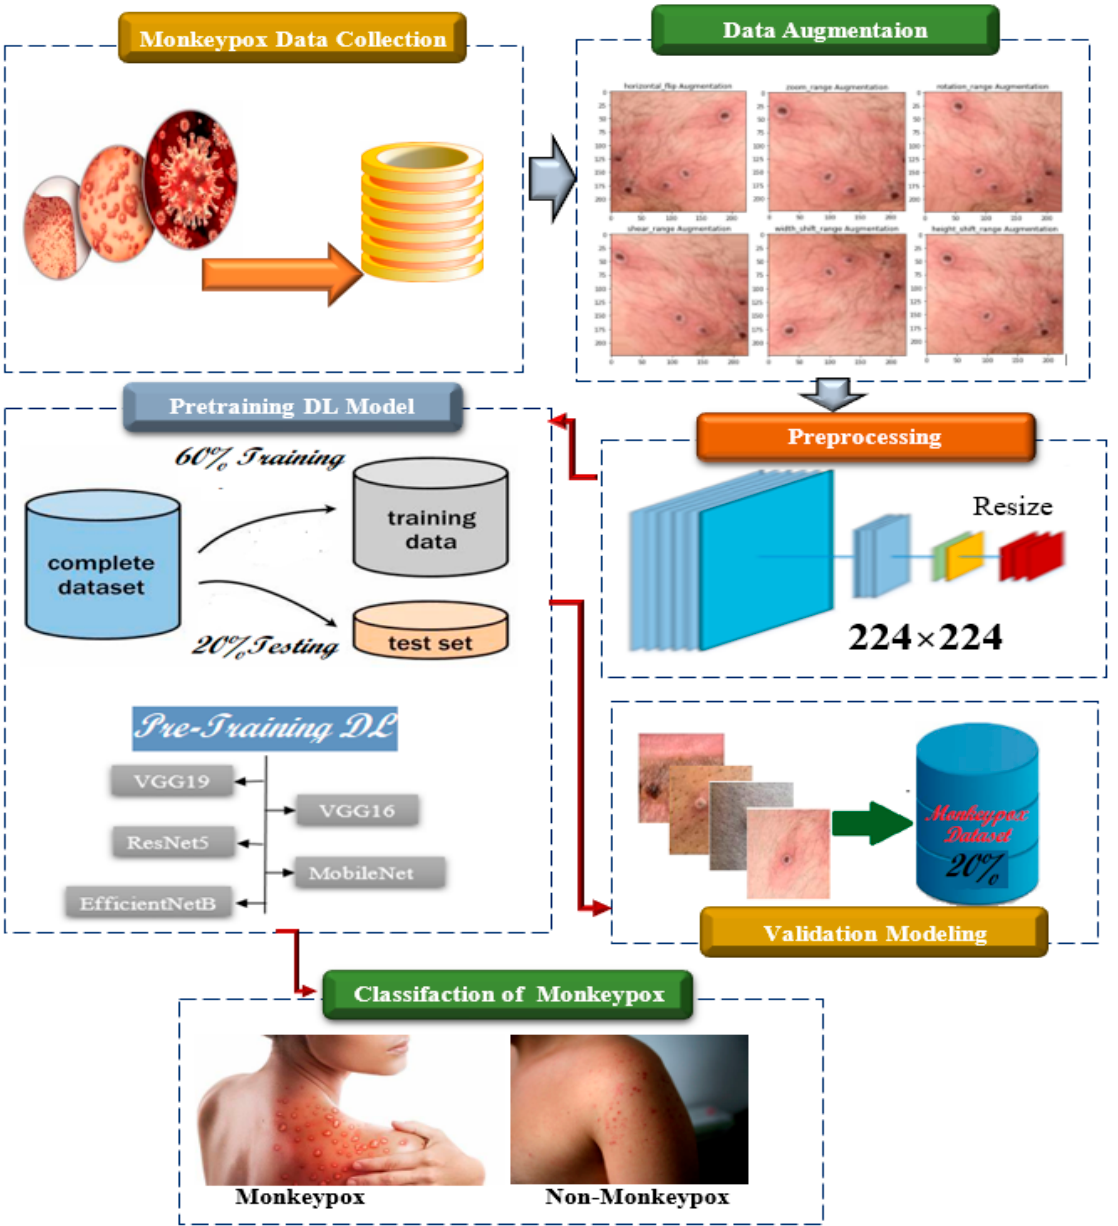
Figure 1. The steps and procedures included in the proposed approach.